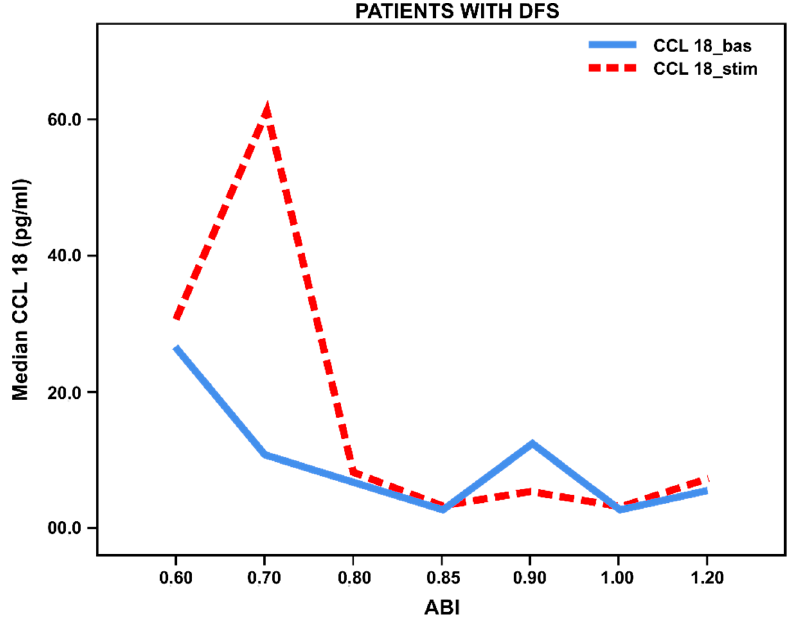
Figure 4. Basal and stimulated СС L18 secretion (pg/mL) by blood-derived monocytes from patients with long-term T2DM ( n = 42) with foot ulcers, depending on ABI (ankle–brachial index). Lines reflect median values.